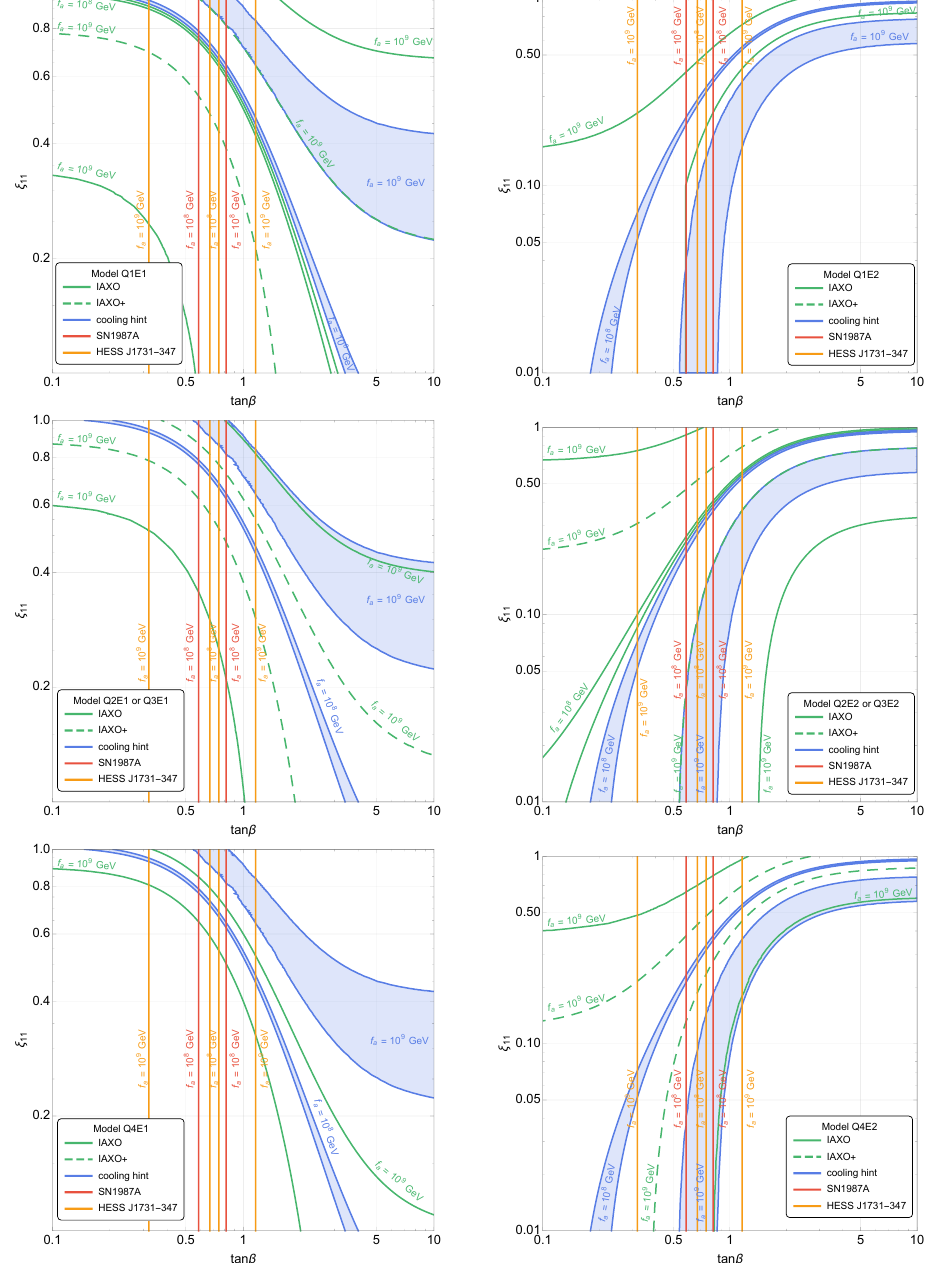
Figure 2 . Projected potential of IAXO (green) and stellar cooling hint region (blue). For the indicated values of f a IAXO can probe the entire region between the solid green curves, while the dashed green contours show the region that can be tested by IAXO+ using a series of possible upgrades [57]. The blue regions are the 1 σ cooling hint contours for a fixed value of f a . The SN1987A and the neutron star bound from HESS J1731-347 [18] are given by the red and yellow curves,